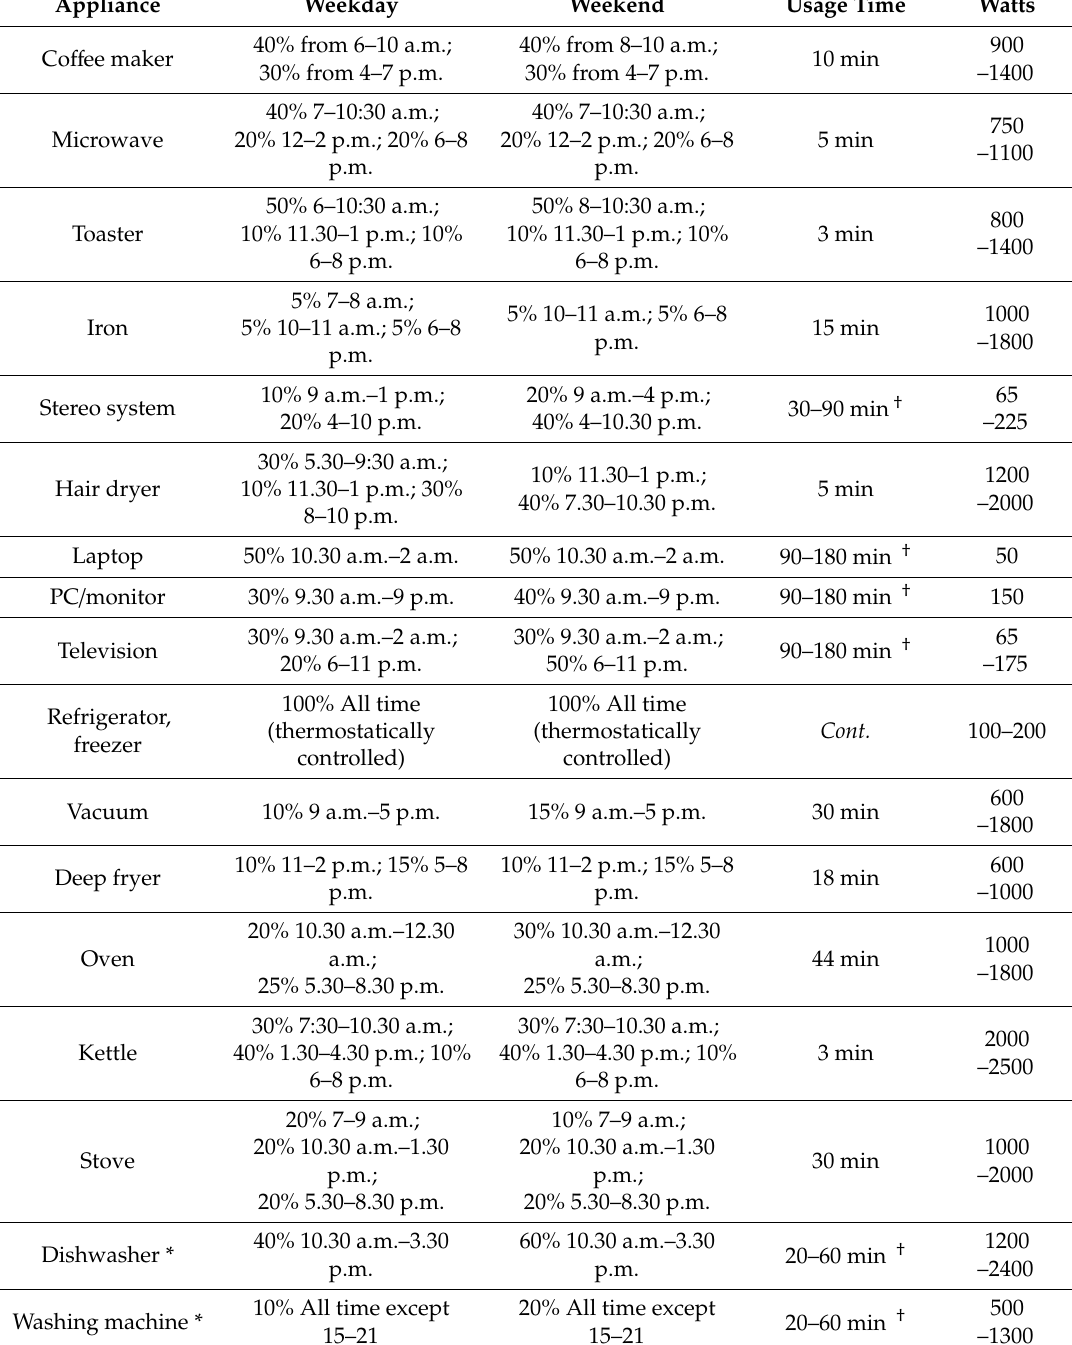
Table 1. Daily appliance consumption in weekdays and weekends. PC—personal